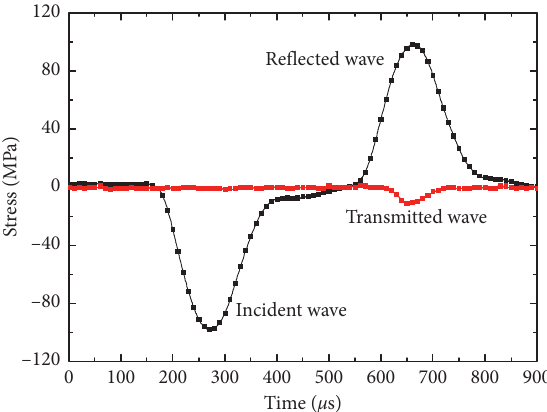
Figure 6: Typical stress wave during the dynamic Brazilian